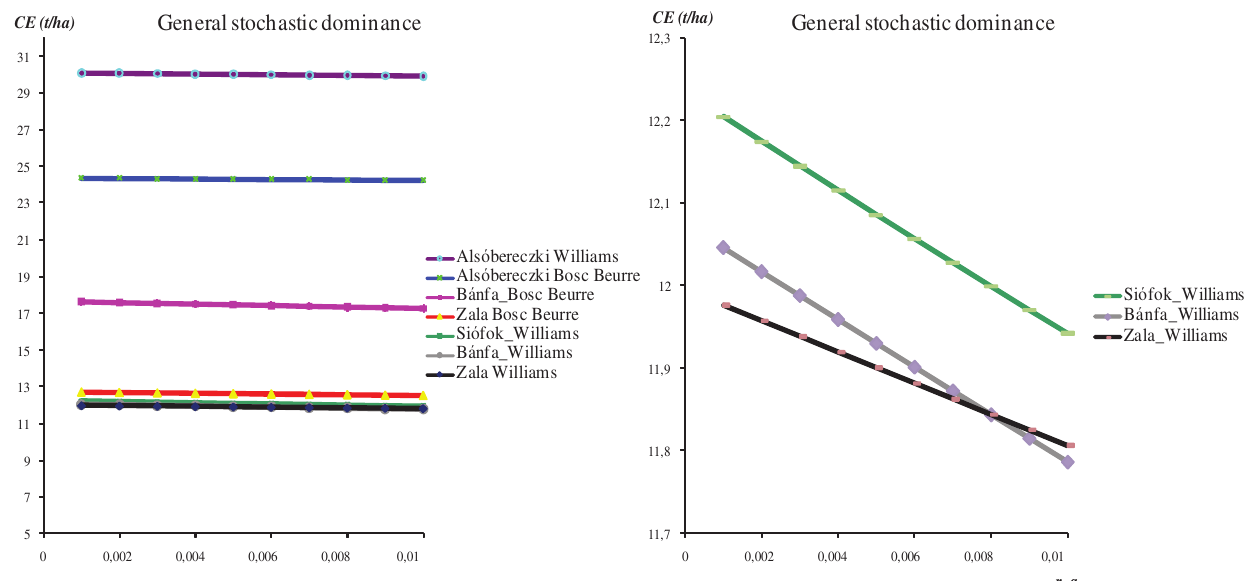
Figure 6 . Certainty equivalent curves for the yield risk of the examined four plantations and for the two varieties, depending on the risk aversion value ( ra ) of the decision